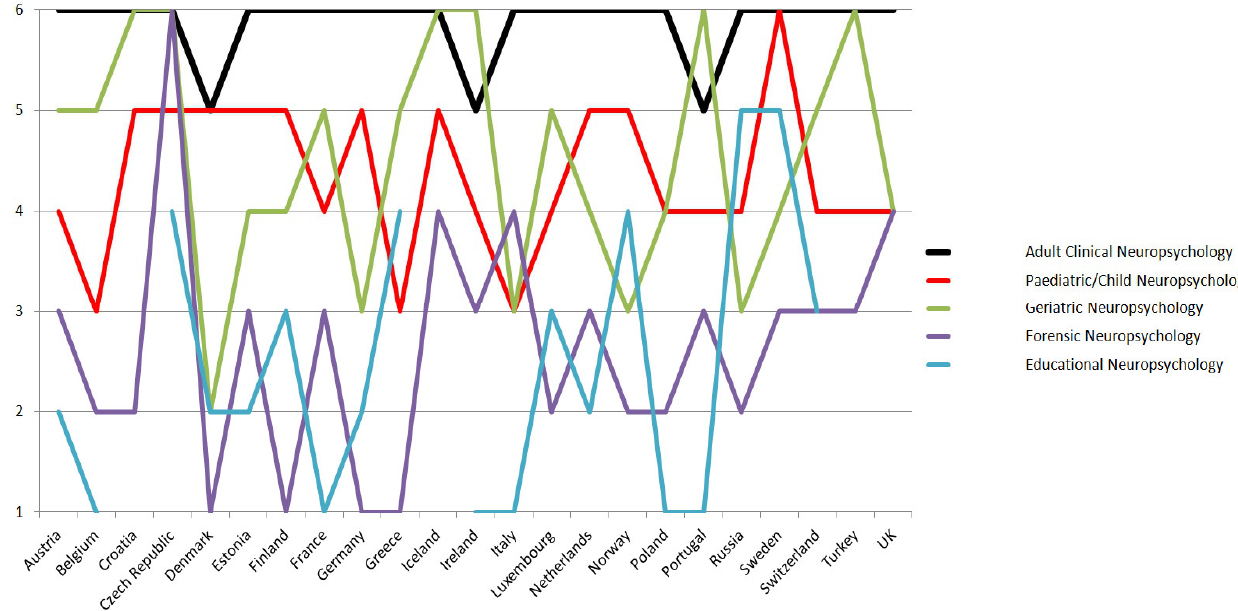
Figure 1. Areas of practice listed from least common (1) to most common (6). If fields of work were considered equal, the same value could be assigned multiple times. The choice “other” is not included in this figure; data from Spain are missing.